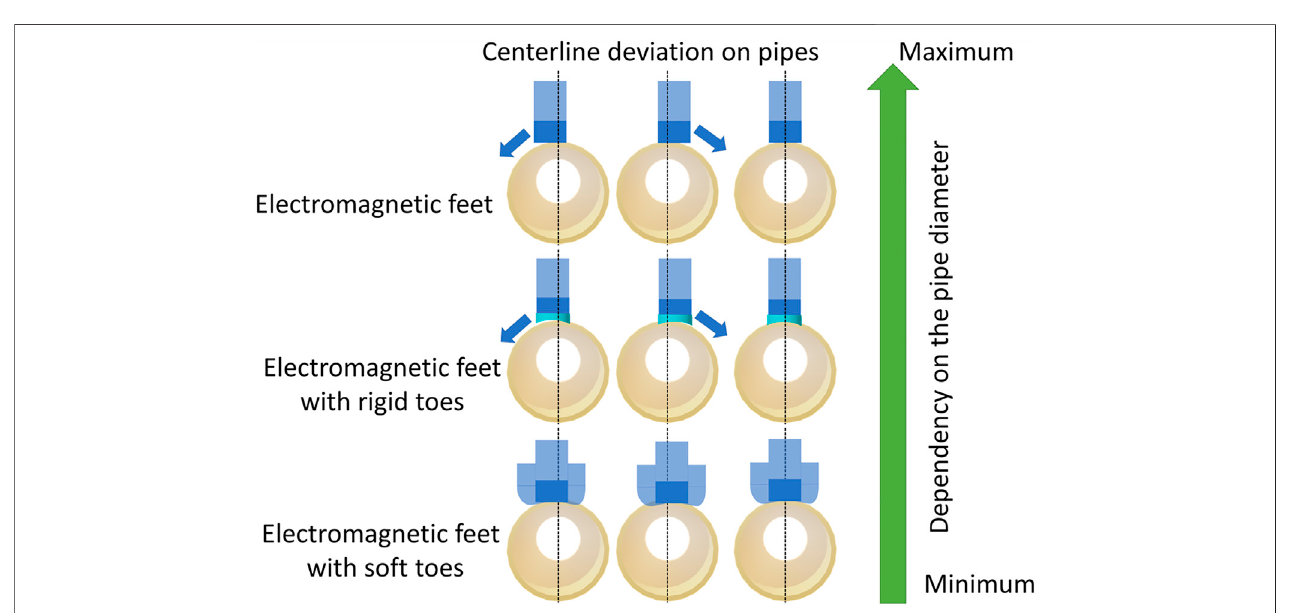
FIGURE3| Aschematicviewoftherobotfeetandtheirstablemovementdependencyonthepipediameter.Electromagneticfeetwithsofttoescanadapteasilyto different pipe diameters as compared to the feet with rigid toes and fl at electromagnetic feet.